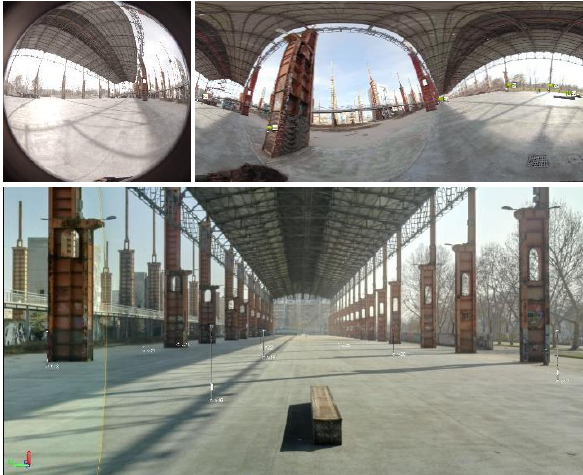
Figure 10. An example of spherical image from GoPro Fusion 360° (one fish-eye hemisphere), and planar view; (bottom) adjusted camera station points from V10 Trimble